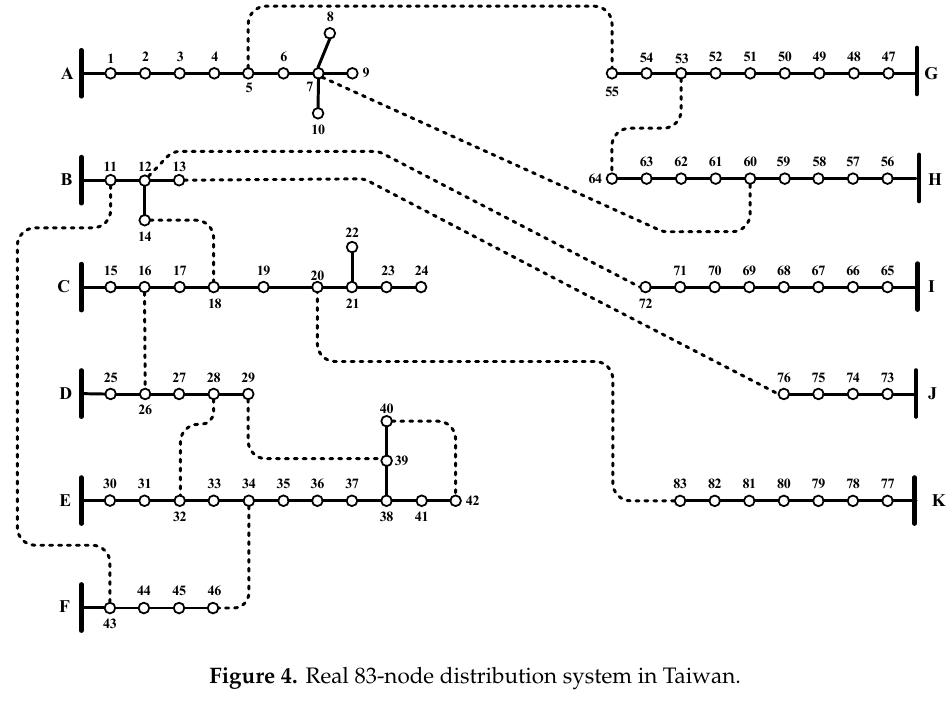
Figure 3. Real 59-node distribution system in Cairo.